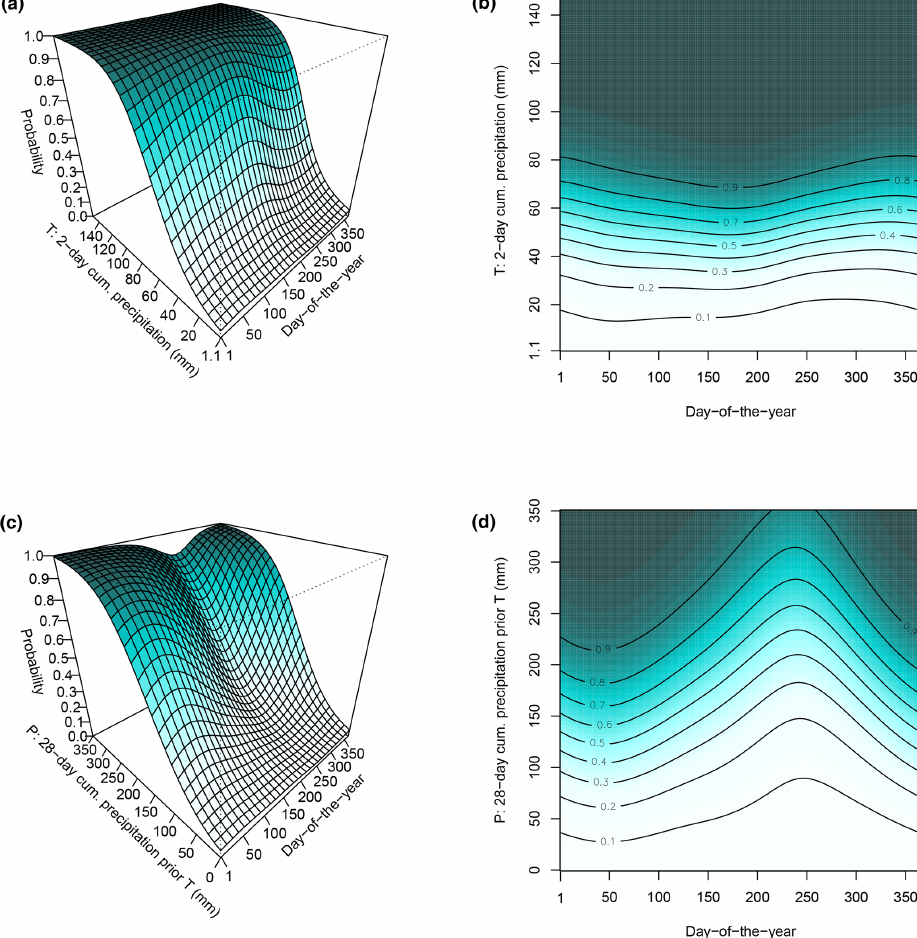
Figure 7. The 3D surface plots (a, c) and 2D surface plots (b, d) depict the modelled effects of triggering precipitation T (a, b) and preparatory precipitation P (c, d) on landslide occurrence within a year (day of the year). The contours and the colour scale show predicted relative probability scores from 0 (white) to 1 (dark green). Note that these plots were created by fixing the not-shown variables ( P in panels a, b ; T in panels c, d ) to their lowest value ( T = 1 . 1; P =